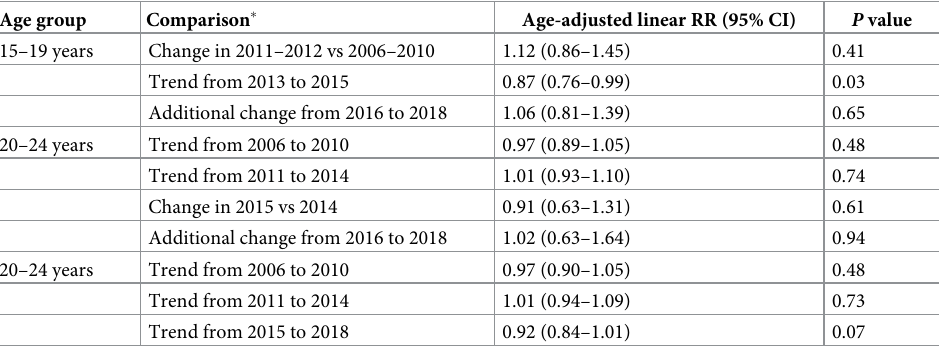
Table 5. Trends in HIV incidence among AGYW, by age and a posteriori calendar time periods in uMkhanyakude, South Africa. Age group Comparison � Age-adjusted linear RR (95% CI) P value 15–19 years Change in 2011–2012 vs 2006–2010 1.12 (0.86–1.45)